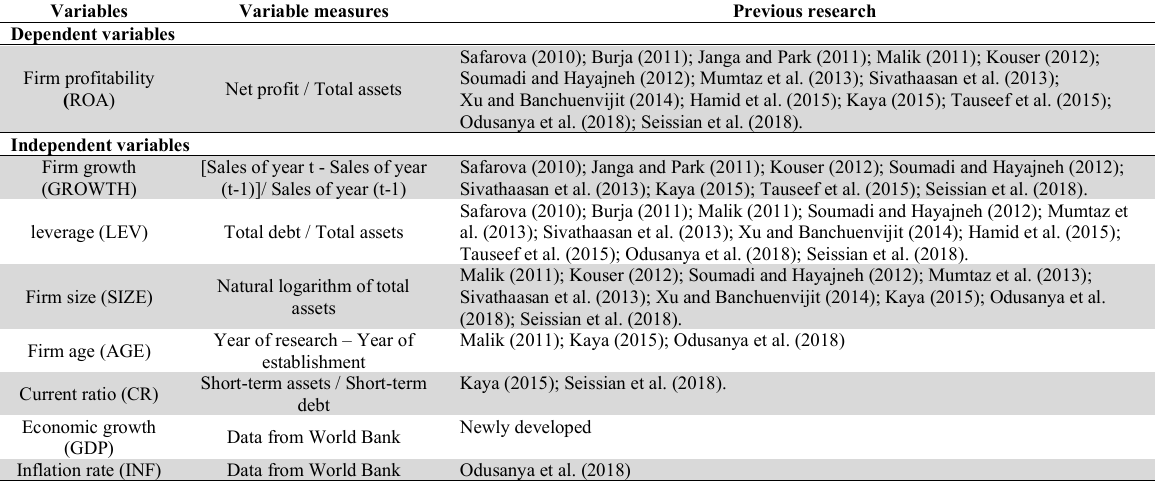
Variables used in the research